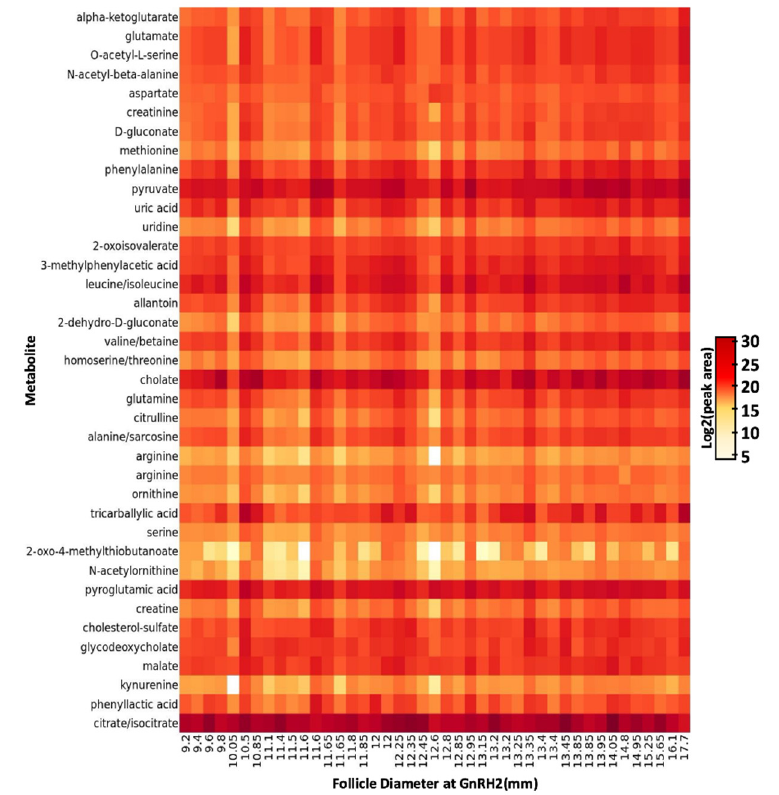
Figure 2. Heatmap of 38 metabolites detected in pre-ovulatory follicular fluid. Metabolites are listed as row titles and the pre-ovulatory follicle diameter at the time of gonadotropin releasing hormone administration to induce a pre-ovulatory gonadotropin surge (GnRH2) corresponding to each follicular fluid sample is listed under each column. Log2 (peak area) of each metabolite within each sample is designated by increasing color intensity. The color intensity scale depicts differences in peak area across all metabolites and demonstrates metabolites present in higher (darker color) and lower (lighter color) concentration in the follicular fluid.